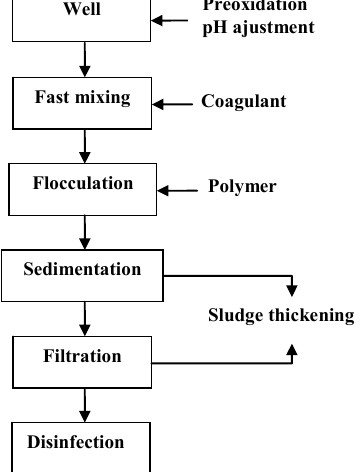
Figure 4. Flow diagram of the arsenic removal plant, Mixco, Guatemala.